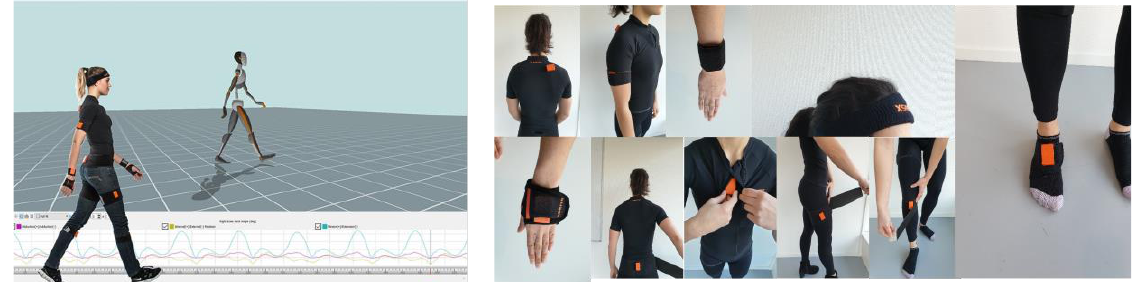
Figure 1. Patients’ recruitment pathway and methodology. Figure 2. Xsens Awinda inertial motion sensors and its location. Figure 2. Xsens Awinda inertial motion sensors and its